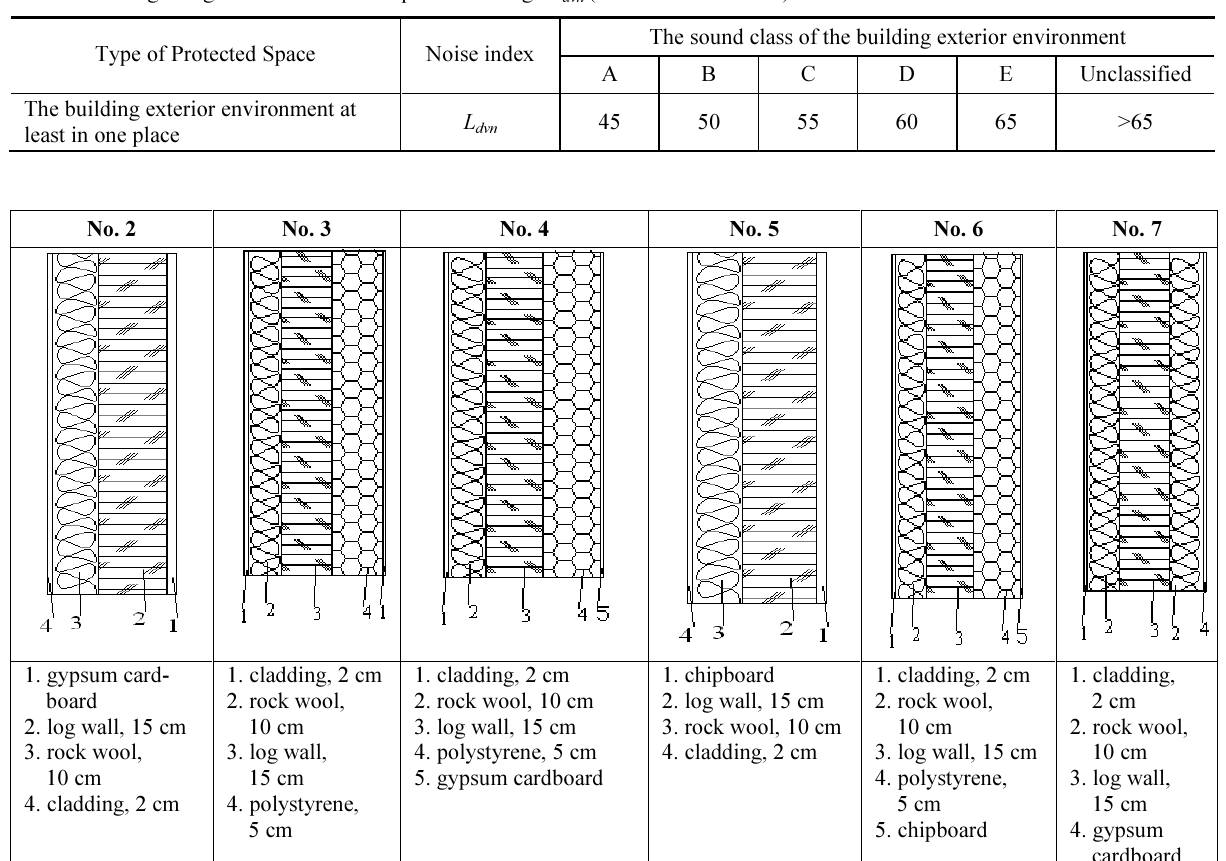
Fig. 7. Structures of experimental specimens of the log